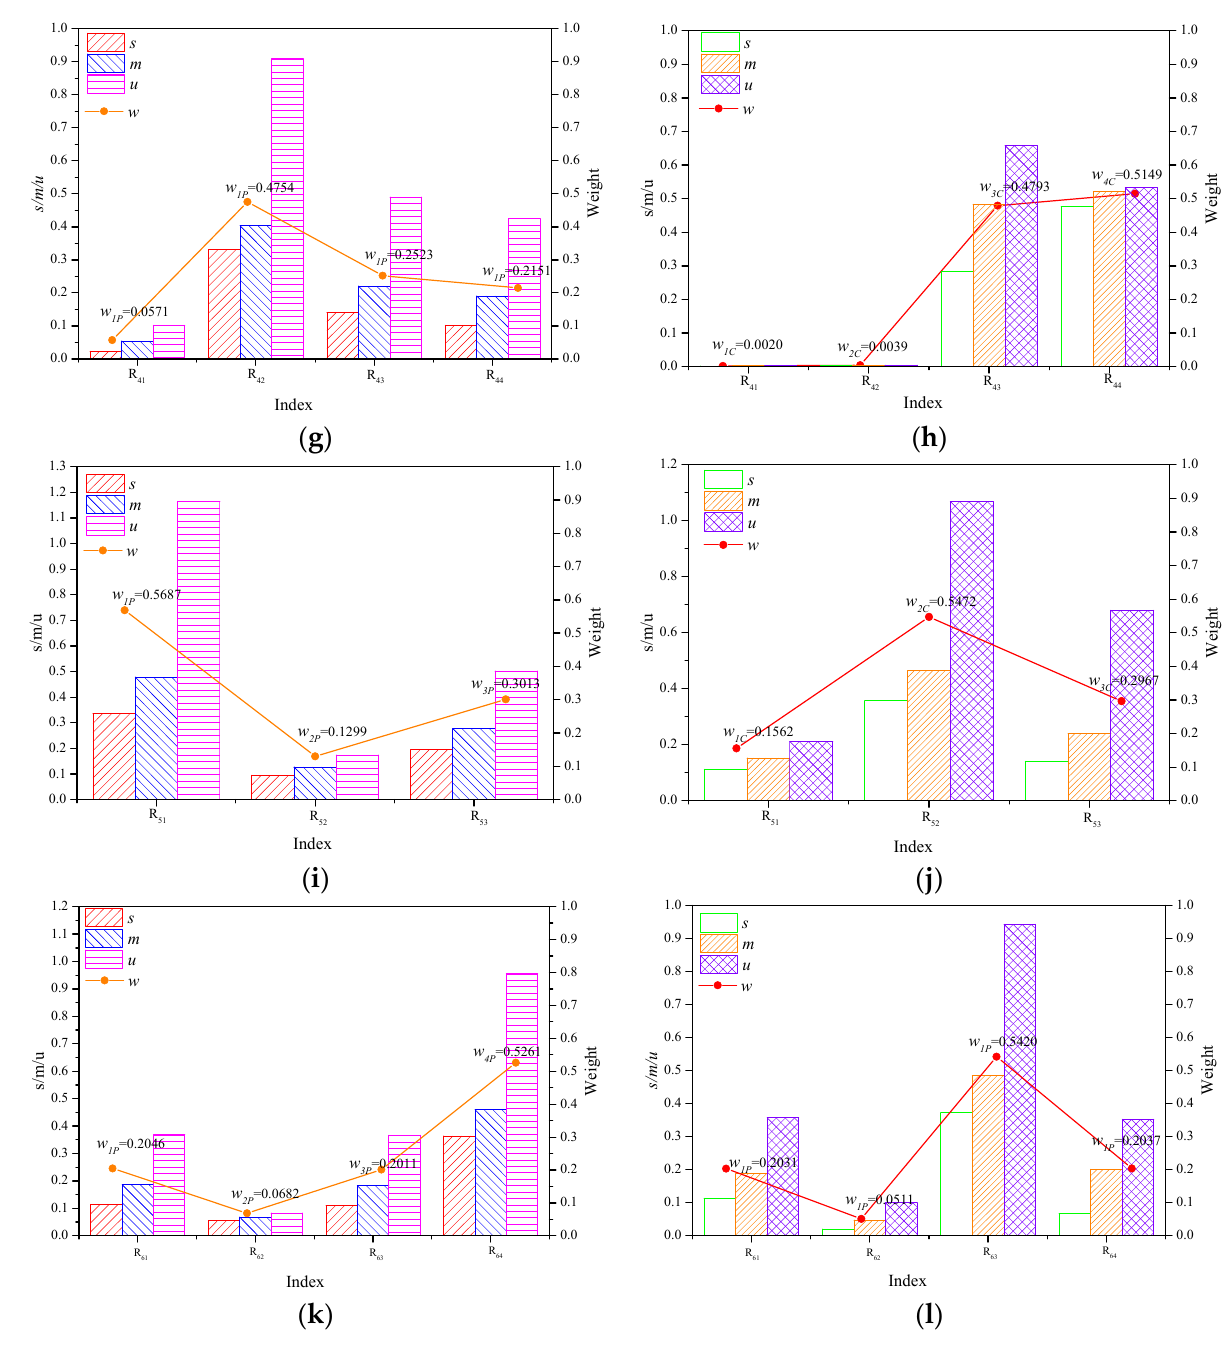
Figure 4. Weight analysis results of secondary indices. ( a ) Weight analysis results of ( P ) (R 11 ~R 15 ), ( b ) weight analysis results of ( C ) (R 11 ~R 15 ), ( c ) weight analysis results of ( P )(R 21 ~R 25 ), ( d ) weight analysis results of ( C )(R 21 ~R 25 ), ( e ) weight analysis results of ( P ) (R 31 ~R 35 ), ( f ) weight analysis results of ( C ) (R 31 ~R 35 ), ( g ) weight analysis results of ( P ) (R 41 ~R 44 ), ( h ) weight analysis results of ( C ) (R 41 ~R 44 ), ( i ) weight analysis results of ( P ) (R 51 ~R 53 ), ( j ) weight analysis results of ( C ) (R 51 ~R 53 ), ( k ) weight analysis results of ( P ) (R 61 ~R 64 ), ( l ) weight analysis results of ( C ) (R 61 ~R 64 ).